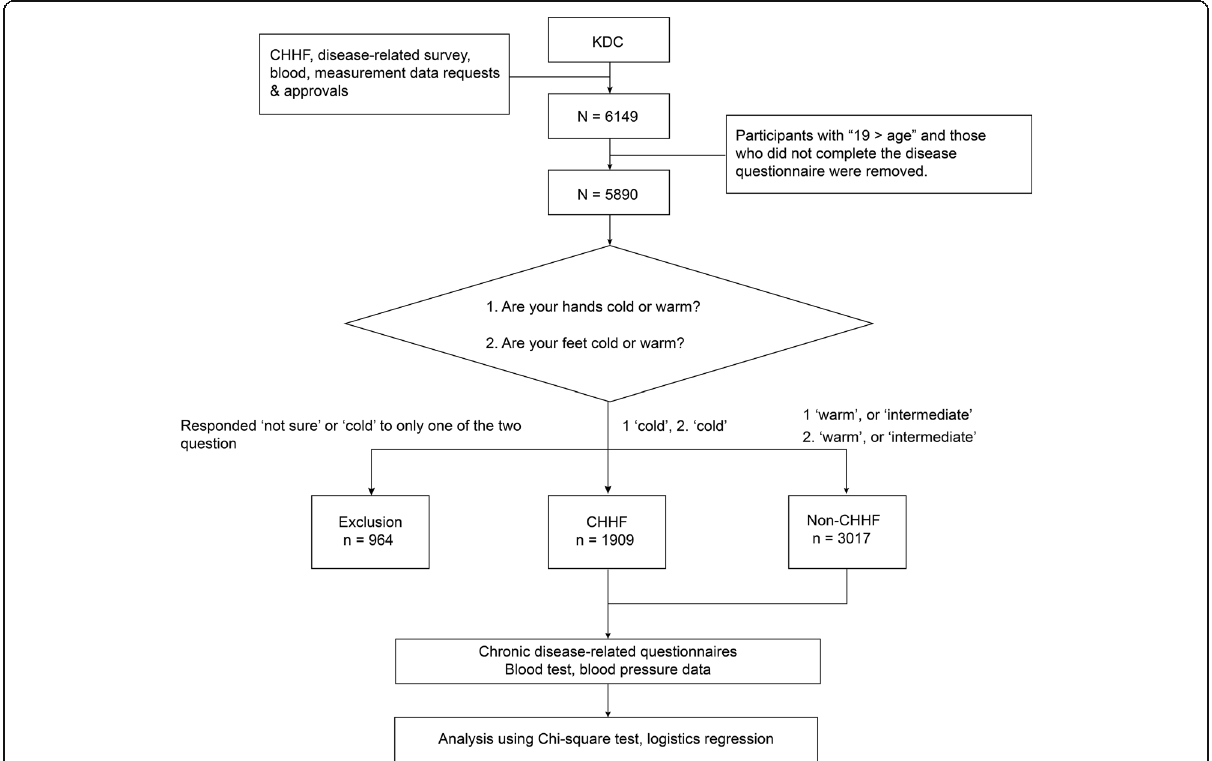
Fig. 1 Flow chart of the study. KDC: Korean Medicine Data Centre; CHHF: cold hypersensitivity in the hands and feet; non-CHHF: non-cold hypersensitivity in the hands and